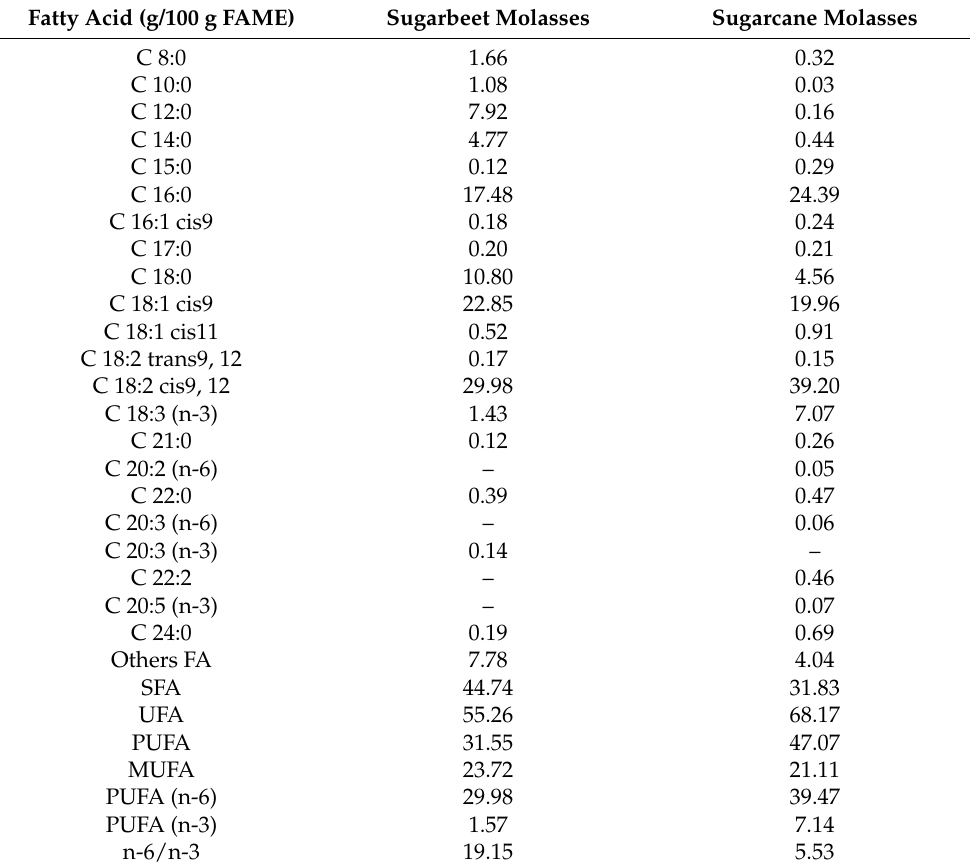
Table 2. Fatty acid composition of sugar beet and sugar cane molasses lipid